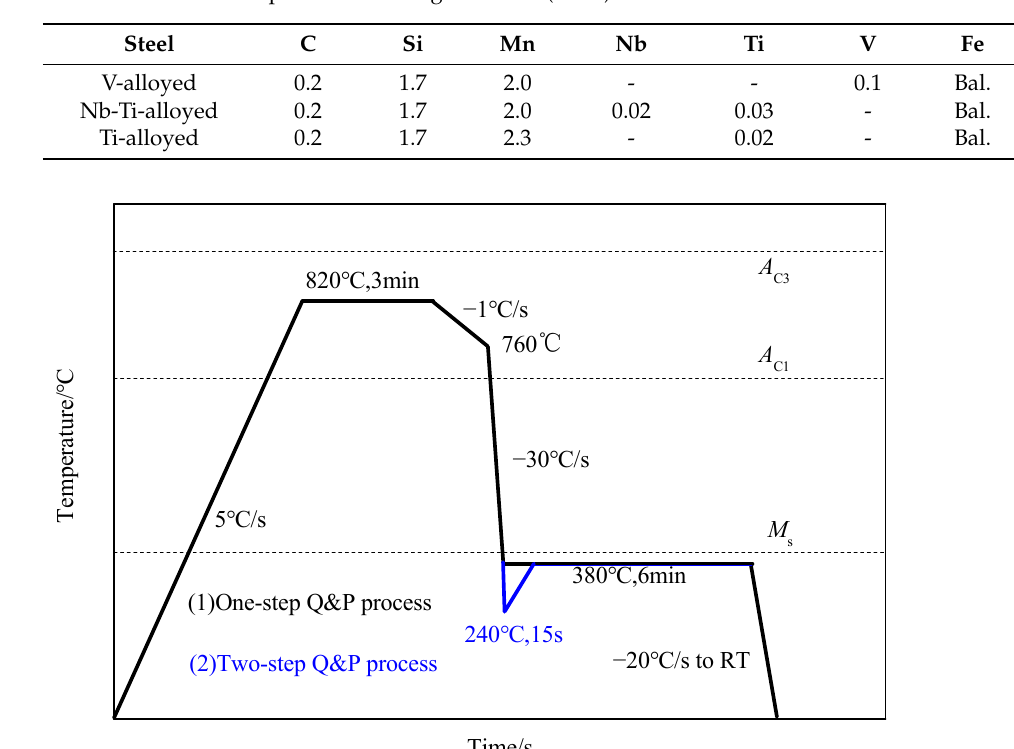
Figure 1. Schematic map of the quenching and partitioning (Q&P) process.